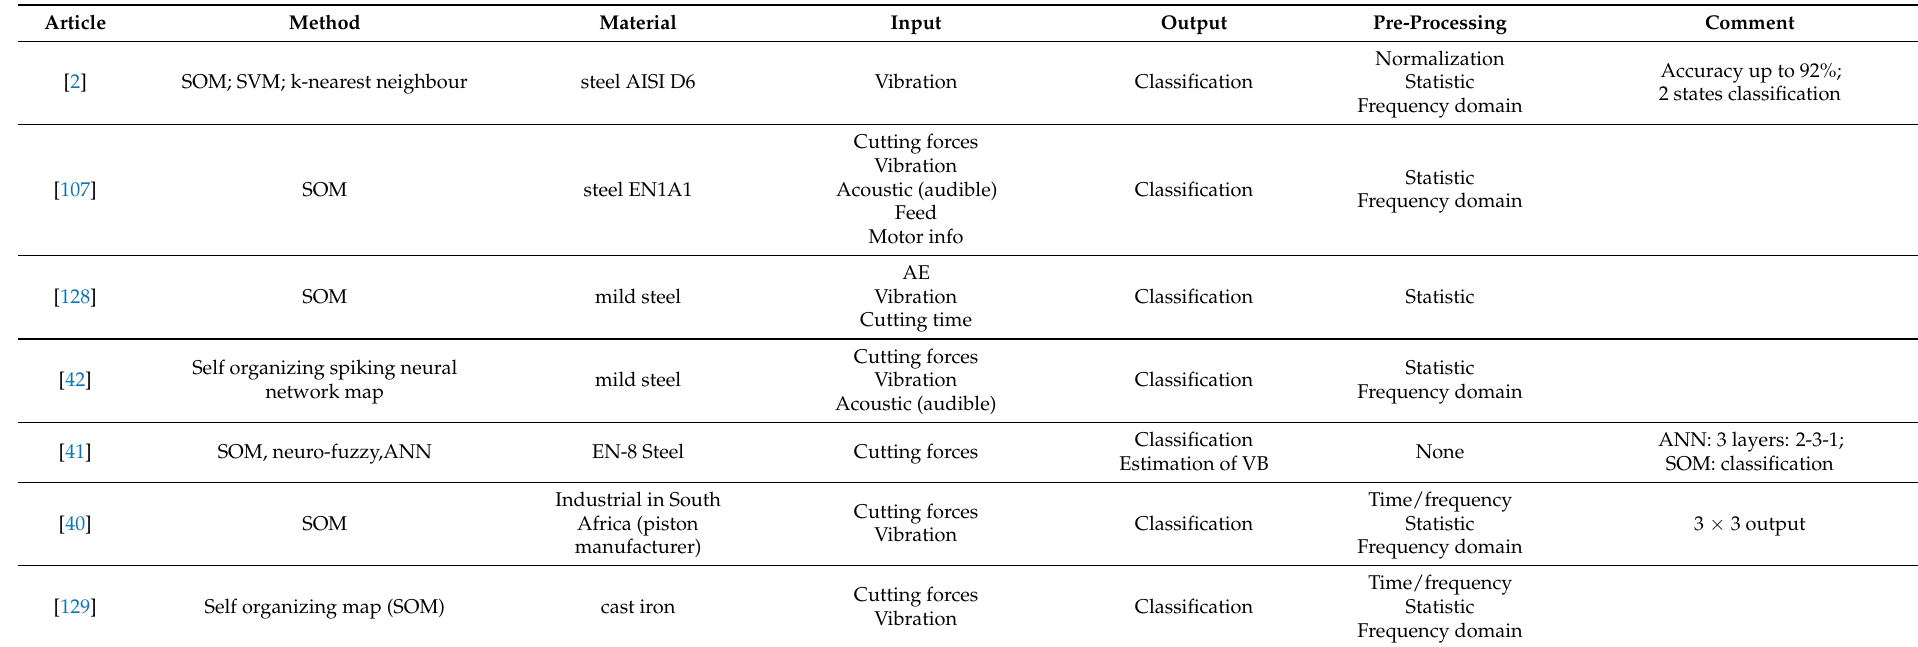
Table A5. General summary of SOM-related publications.